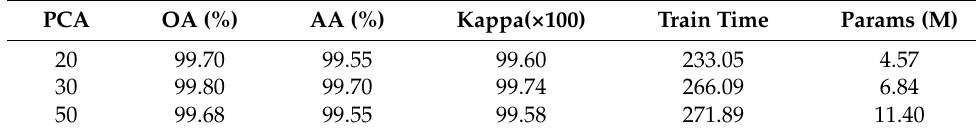
Table 4. Experimental results with different PCA coefficients on the PU dataset.